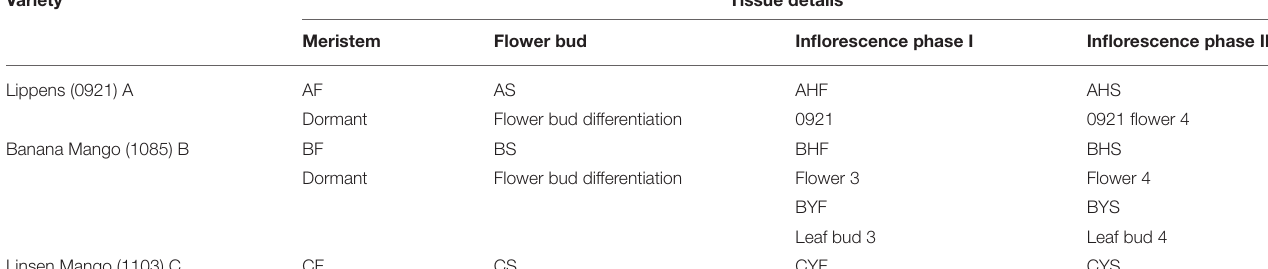
TABLE 1 | Details of the studied tissues of three mango varieties.